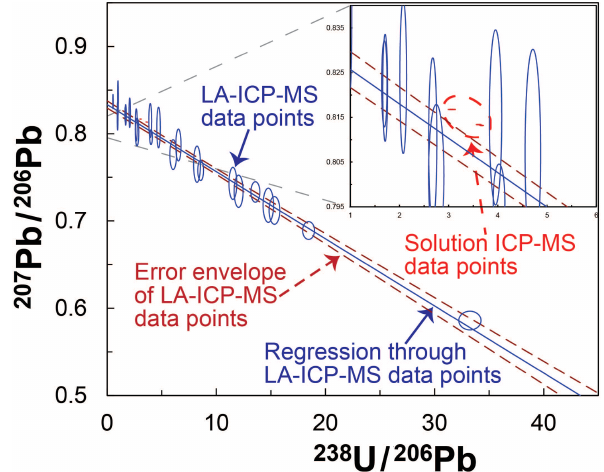
Figure 7. Tera–Wasserburg diagram showing the comparison be- tween laser ablation ICP-MS and solution ICP-MS data points. The error envelope of LA-ICP-MS data points is plotted with Isoplot 3.7.5 (Ludwig, 2012). All ratios are uncorrected for initial Pb. Data- point error ellipses are 2 σ